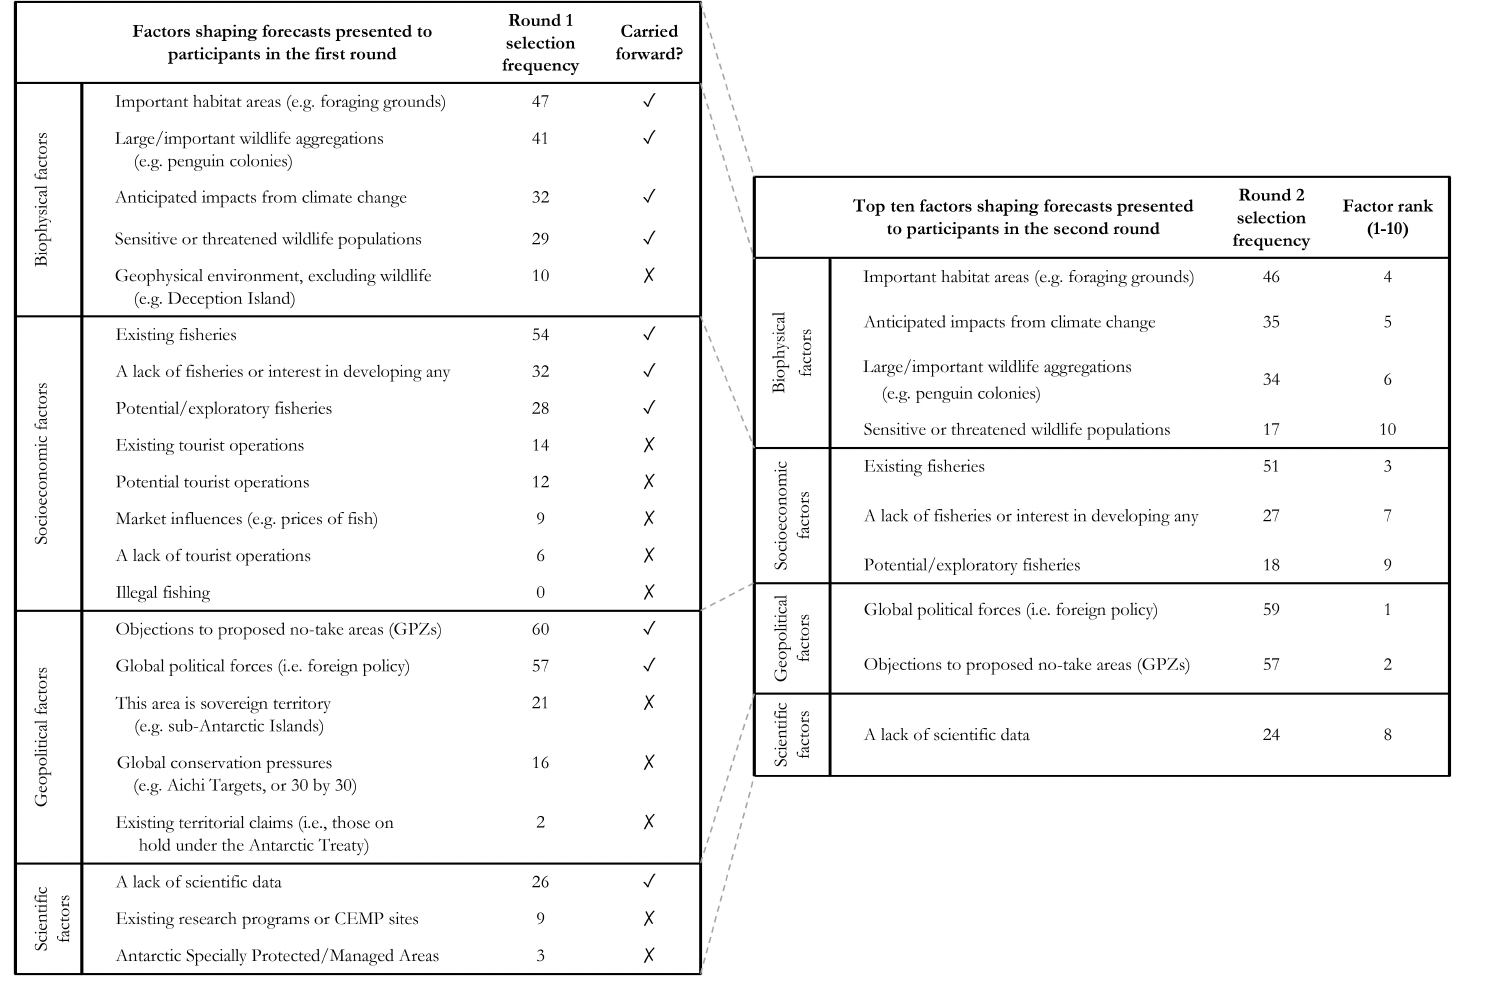
Selection frequency is the number of times experts noted the factor as being important [out of a possible total of 100 (ten participants × ten areas)]. “Carried forward” indicates whether or not it ranked in the top ten and was therefore selected for use in the second round of the elicitation. Table includes all ten of the factors carried forward and presented to experts in the second round of the